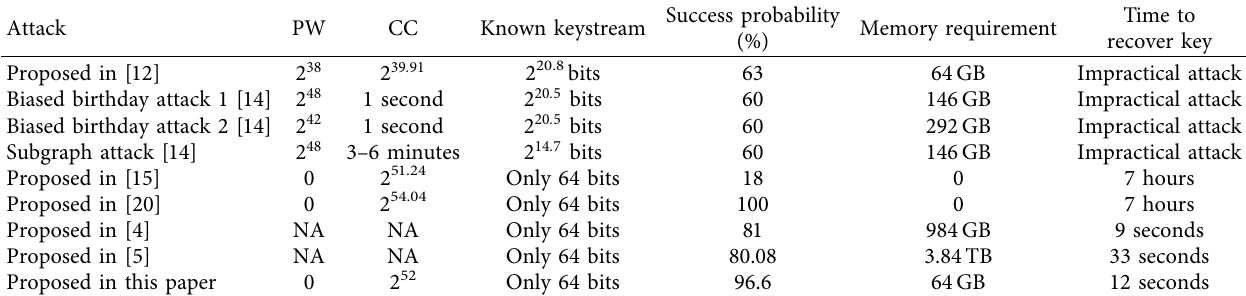
Table 3: Comparison of related attacks (PW: precomputation workload; CC: computational